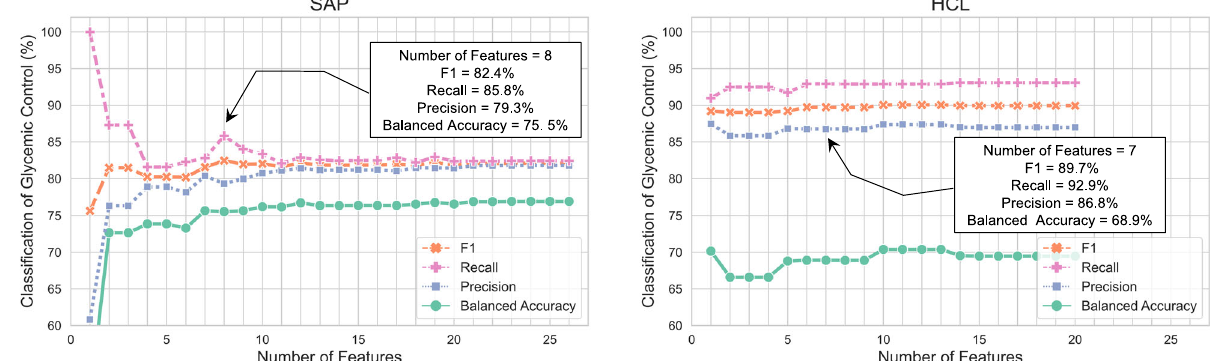
Fig. 4 Feature importance analysis for classi fi cation of glycemic control. The classi fi cation results for the SAP and HCL dataset plateaued after inclusion of the top 7 – 8 objective features. This fi gure shows the results obtained with a logistic regression classi fi er.